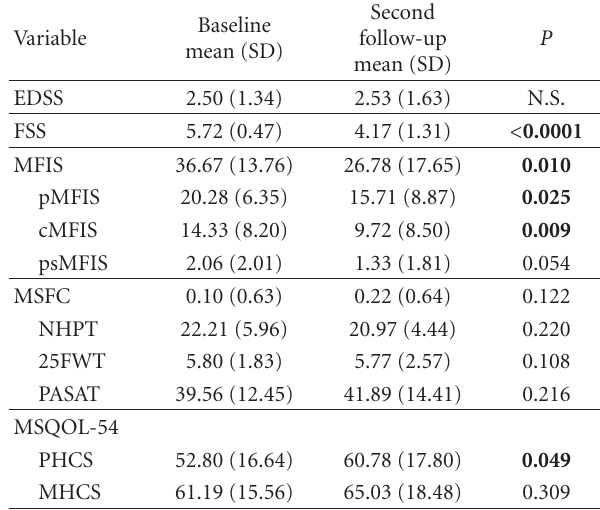
Table 2: Mean clinical variables scores at baseline and 6 months after treatment ( n =